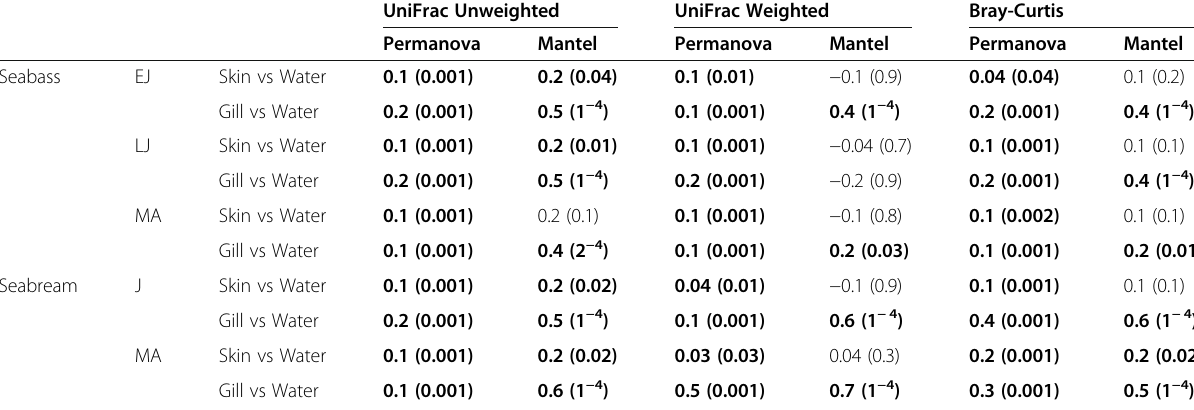
Table 2 Results from pairwise comparisons of beta-diversity and Mantel tests for fish tissues and water per age group for the seabass Dicentrarchus labrax and the seabream Sparus aurata ( n = 60 per species x age group for tissues; n = 10 per species x age group for water) UniFrac Unweighted UniFrac Weighted Bray-Curtis Permanova Mantel Permanova Mantel